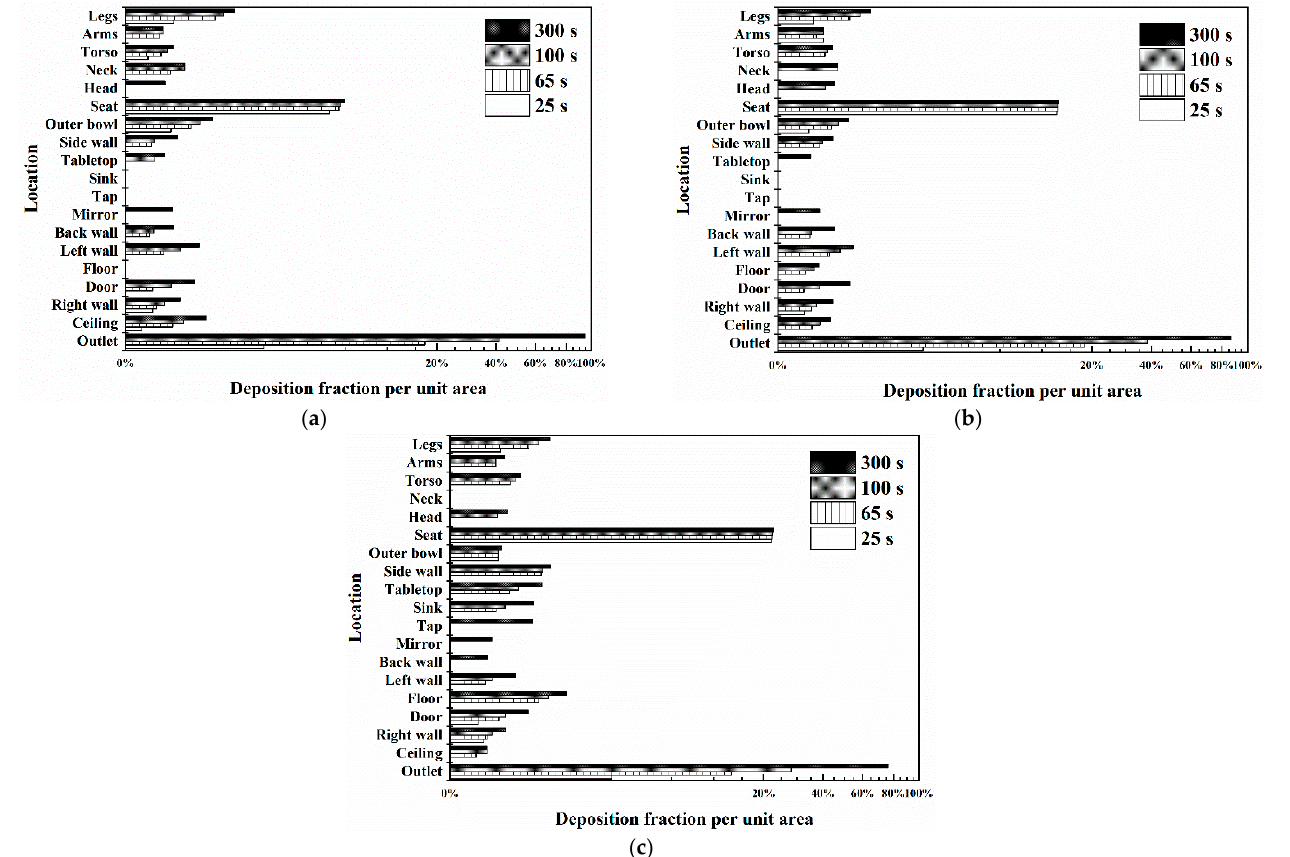
Figure A1. Velocity profiles of the middle cross-section of the outlet flushing by time.